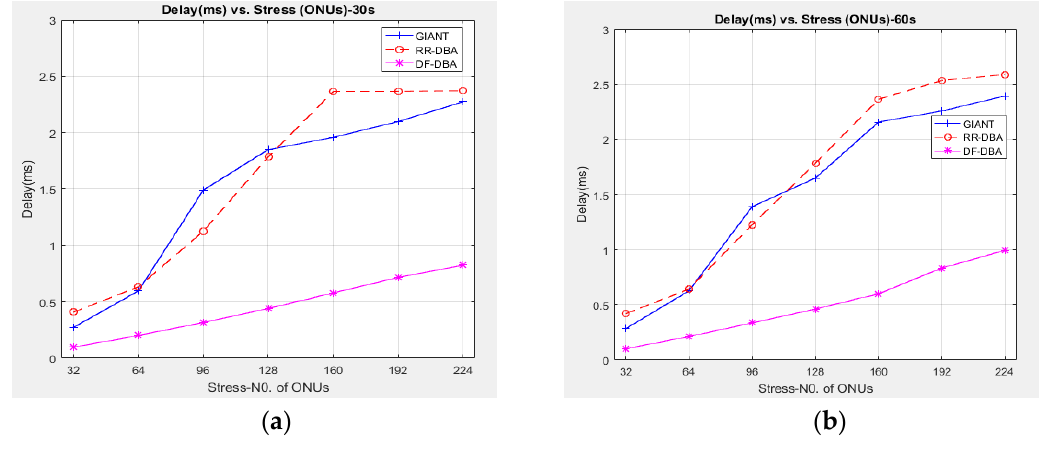
Figure 7. Delay Analysis. ( a ) Delay (ms) vs. Stress (ONUs) -30s. ( b ) Delay (ms) vs. Stress (ONUs) -60s.